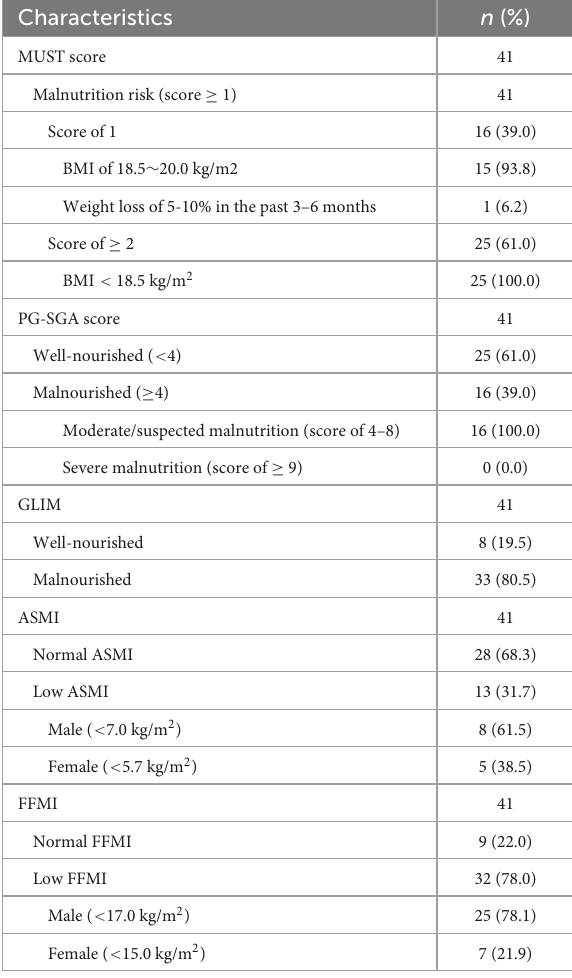
TABLE 5 Characteristics of patients with NRS-2002 ( − ) and MUST (+) ( n = 41).